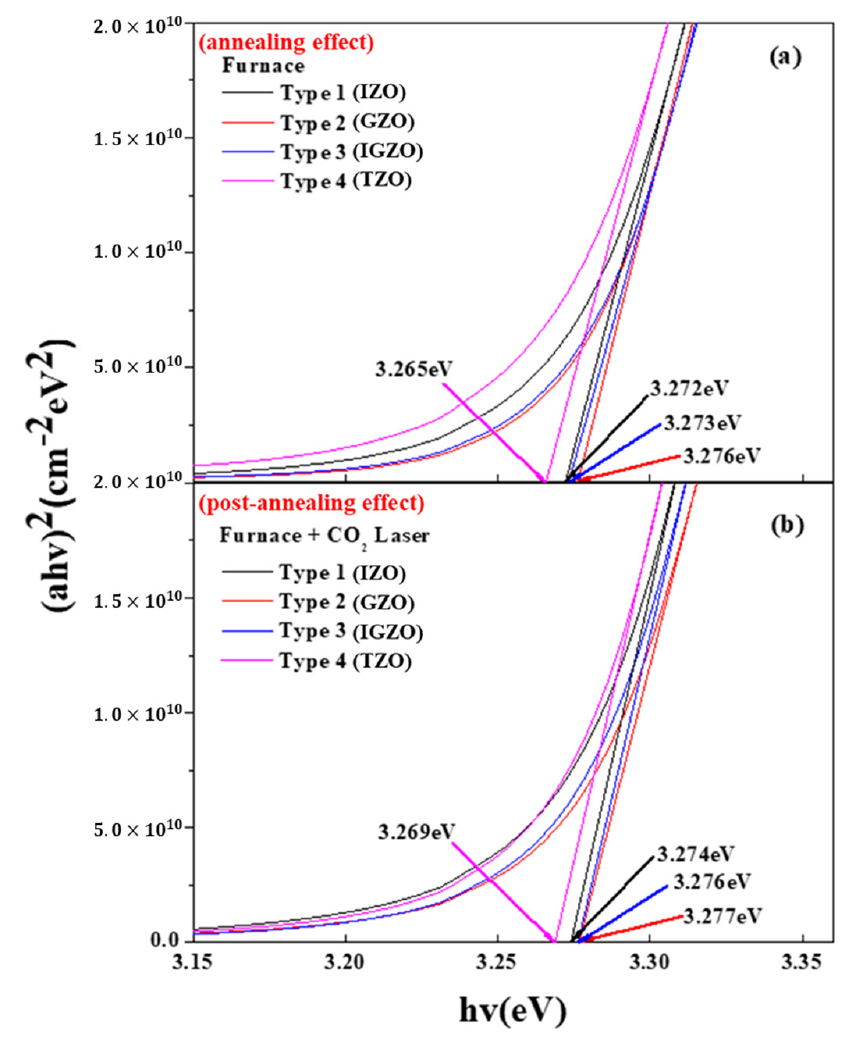
Figure 7. Energy band gap of 4 types of (In, Ga) co-doped multilayered thin films after electrical furnace-annealing effect ( a ) and furnace & CO 2 laser annealing–post-annealing effect ( b ).